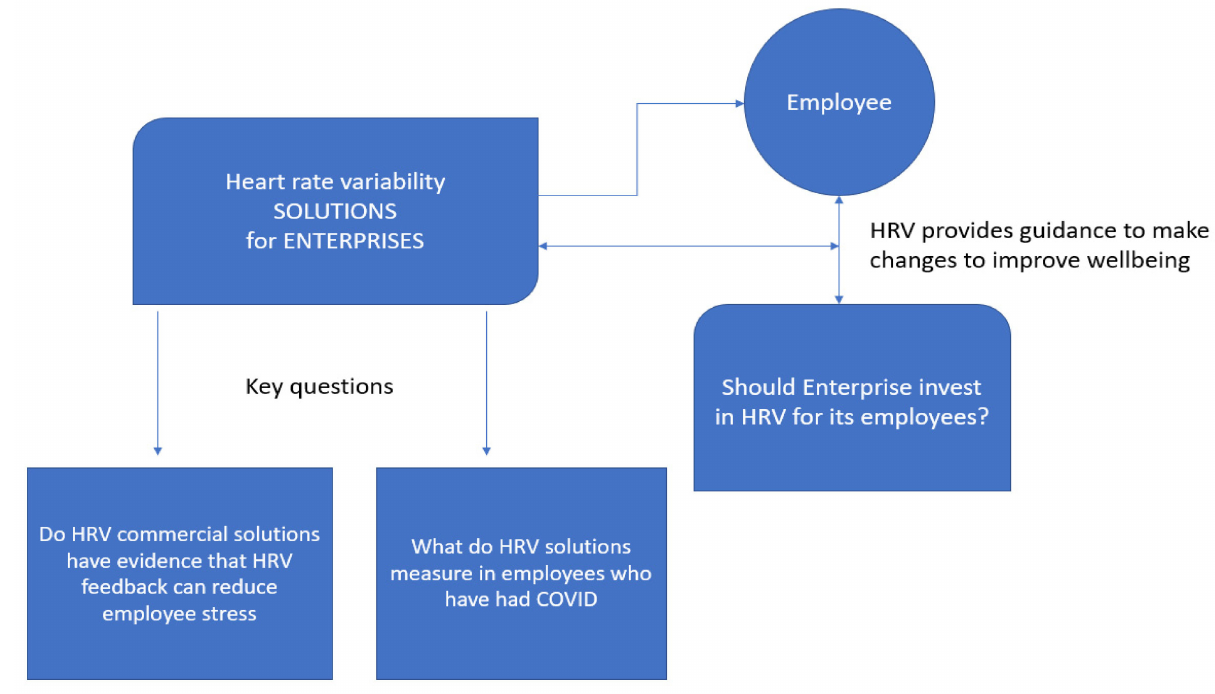
Figure 1. Key theoretical concepts and observational gaps emerging from the literature review: (i) accuracy and sustainability of a HRV tracking solution for identifying employee stress; (ii) it remains unknown whether HRV solutions to monitor stress are accurate in employees who have had